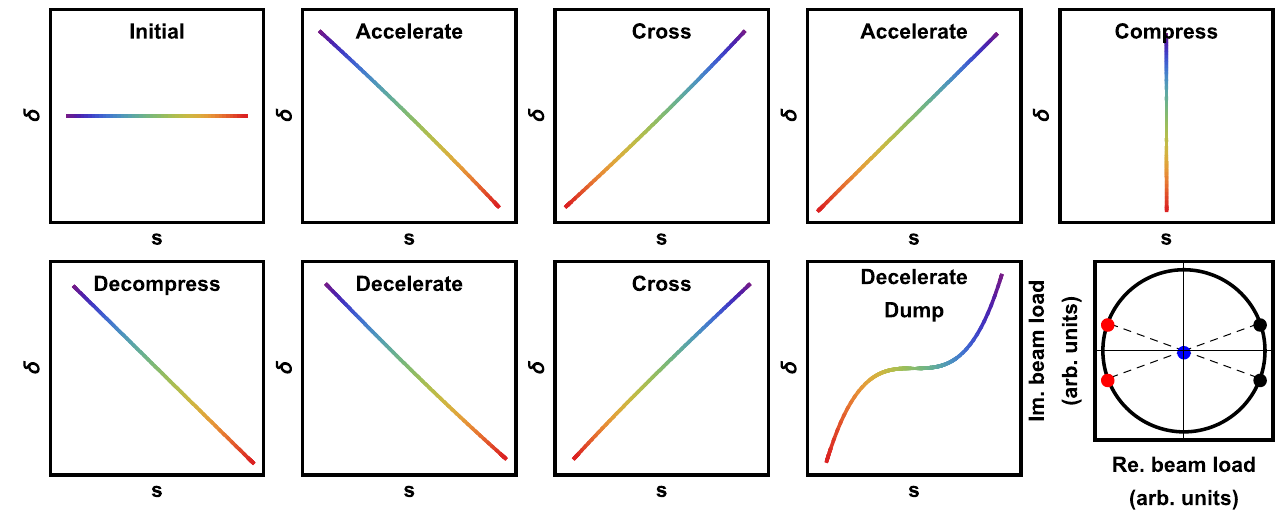
FIG. 17. Longitudinal match solutions using parasitic crossings to cancel rf curvature in common transport. rf beam load plot (bottom right) shows phase choices during acceleration (black), deceleration (red), and resultant (blue).